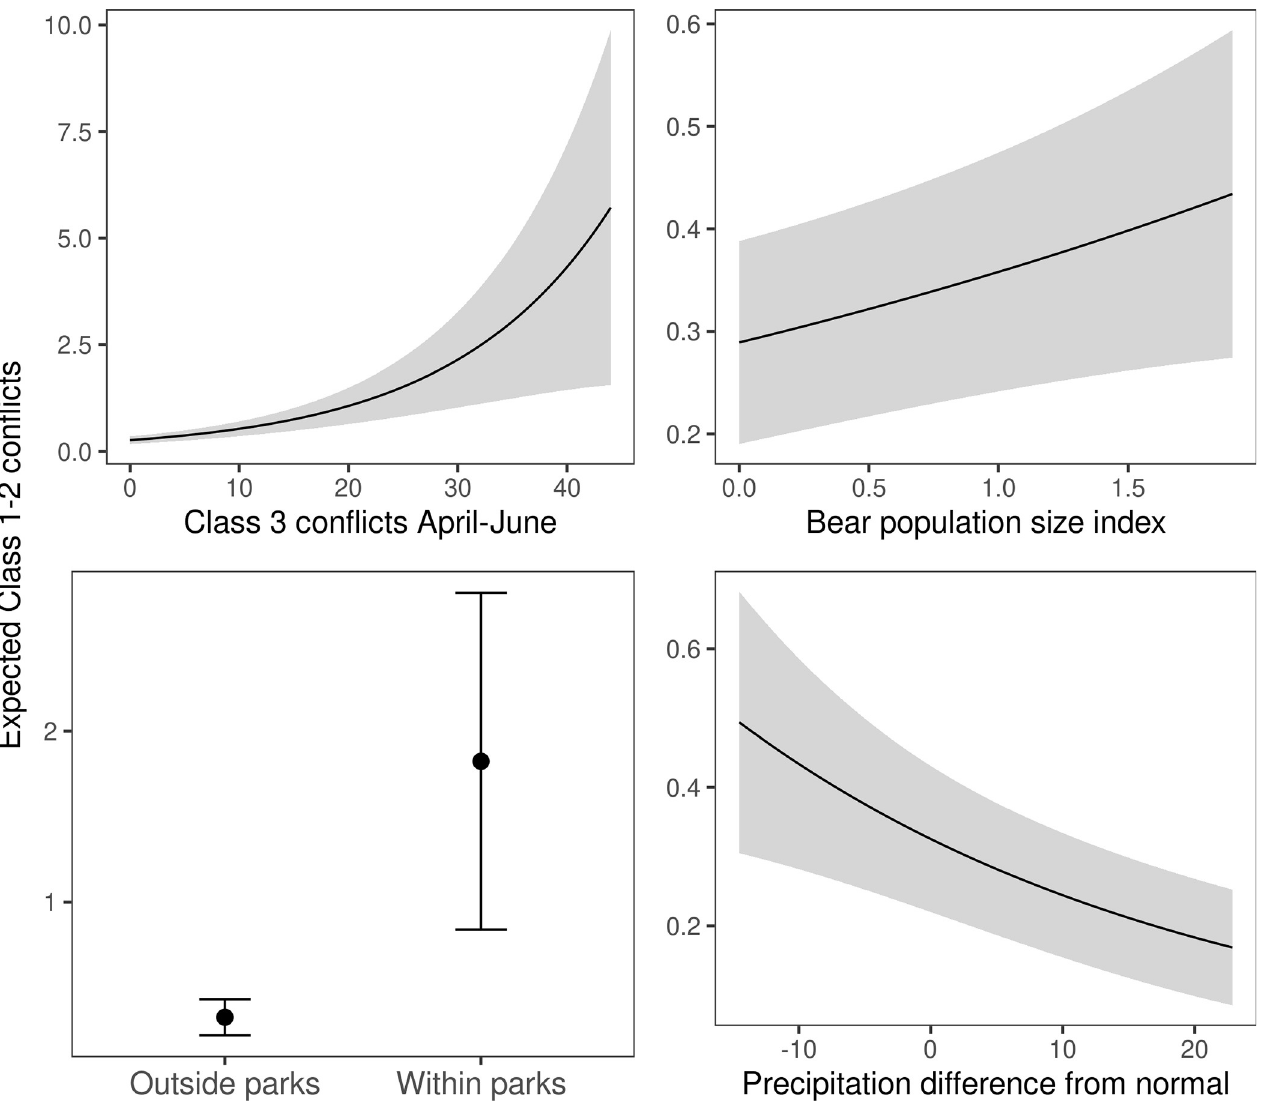
Fig 3. Effects of covariates included in the top model on high or moderate severity (Class 1–2) human-black bear conflicts, New York, USA, July– September 2006–2019. Shaded area and error bars represent 95% confidence intervals. For each panel, non-focal covariates were held at median values (mild severity conflicts, abundance index, precipitation) or 0 (protected